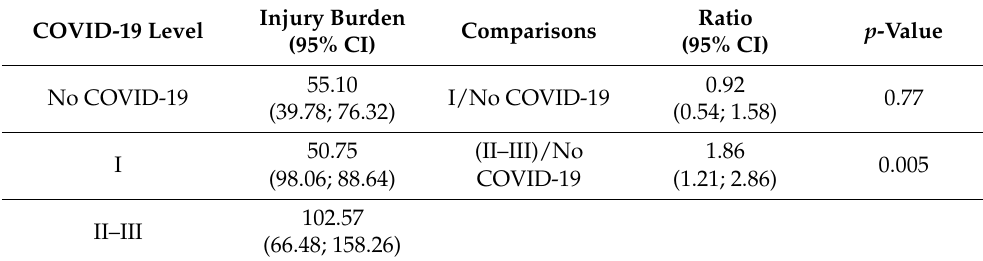
Table 4. Injury burden was defined as the total amount of days lost due to injuries for each player, scaled to 1000 h/player of exposure. Injury burden was estimated by modeling injury time for each patient using a GLMM with exposure time entered as an offset term.